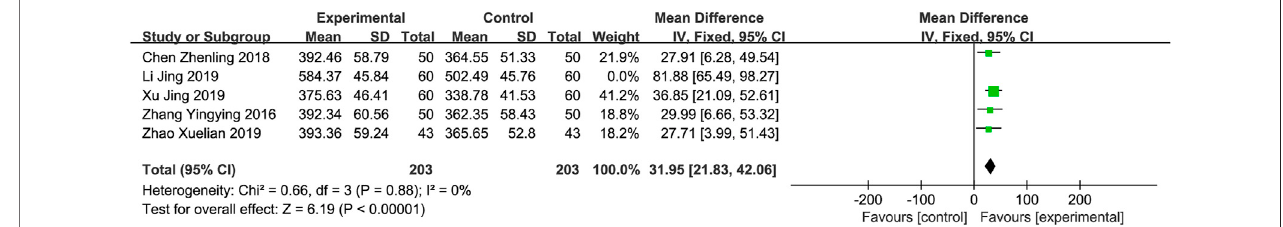
FIGURE 8 | Forest plot of 6-MWD.